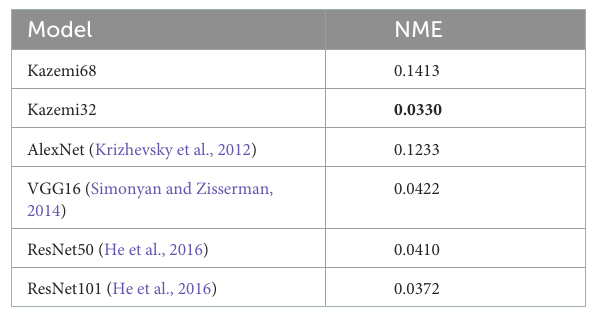
TABLE 1 Feature points detection errors with various models.